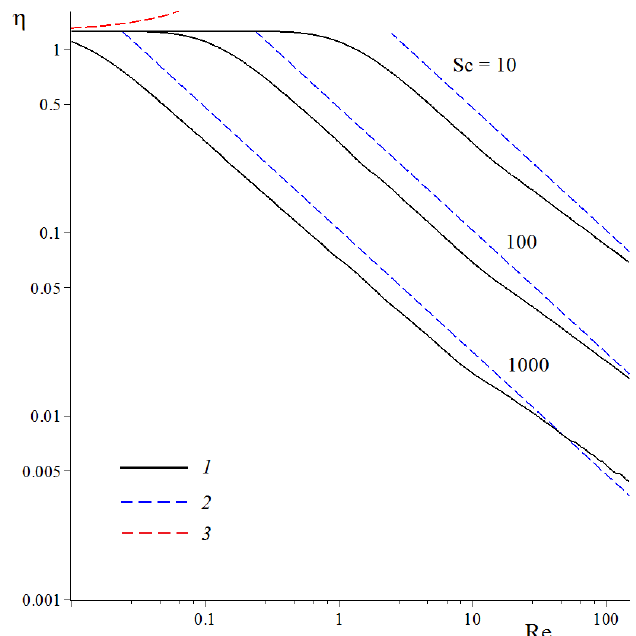
Figure 7. Fiber retention efficiencies per unit length in a dense row of fibers with a / h = 0.8 vs. Reynolds number, found from the combined numerical solution of the Navier–Stokes and convection–diffusion equations (curves 1 ): Schmidt numbers are marked on the curves; curves 2 were plotted by Equation (10) with F = F 0 for the Stokes flow at Re << 1; curves 3 were plotted by the asymptotic formula (Equation (12)) for Pe << 1.